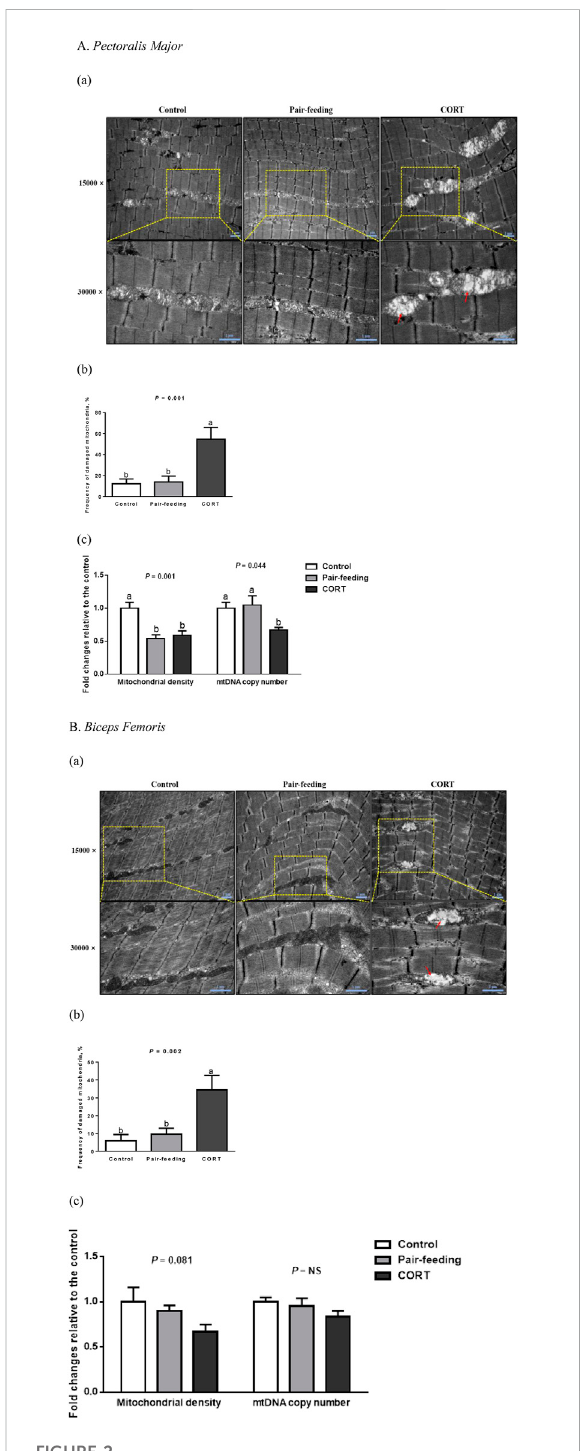
FIGURE 2 Mitochondrial morphology (a , red arrows indicate the ultrastructural injury ) , frequency of damaged mitochondria (b) and mitochondrial quantity (c) in pectoralis major (A) and biceps femoris (B) muscles of broiler chickens treated with corticosterone (CORT, 30 mg/kg diet from 30 to 37 d of age). Data are means of 12 individuals of 2 birds per replicate. a,b Means without a common superscriptdiffer ( p < 0.05).mtDNA,mitochondrialDNA;NS, p >